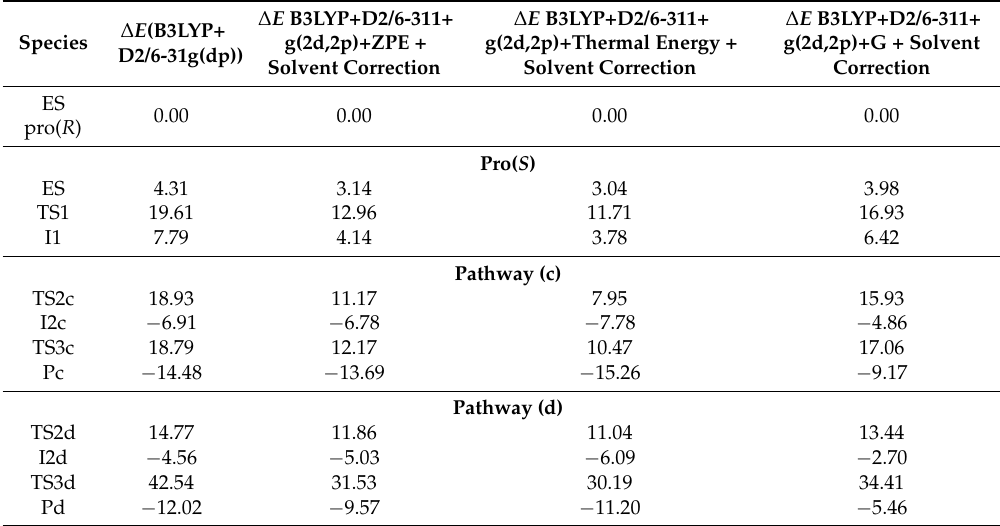
Table 2. The energy profile (in kcal/mol) obtained for cluster modeling of pathways ( c ) and ( d ) (pro( S )) where the benzyl radical attacks the distal carbon atom (C3) of the fumarate (with respect to the Cys493). All energy differences were calculated with respect to ES of pathway ( a